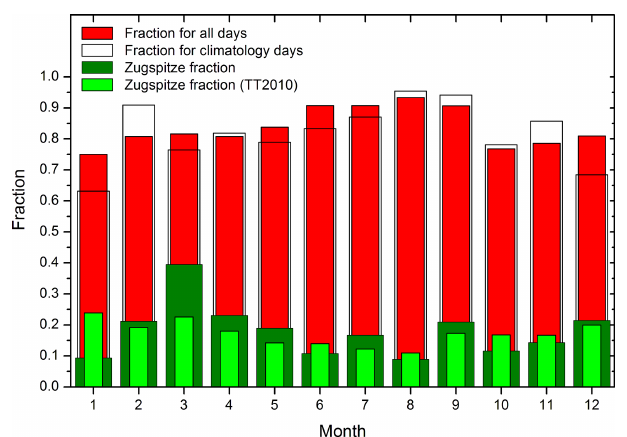
Figure 13. Fraction of intrusion days in the ozone lidar data av- eraged for each month between 2007 and 2016 (see text); we give the fraction for all measurement days (red bars) and for the “cli- matology days” Monday and Thursday (transparent bars). For com- parison, the same analysis is shown for those intrusion days that show stratospheric influence at 2962m (Zugspitze, dark green), to- gether with the maximum fractions calculated from the Zugspitze in situ data underlying Fig. 12 in Trickl et al. (2010, “TT2010”; light green).